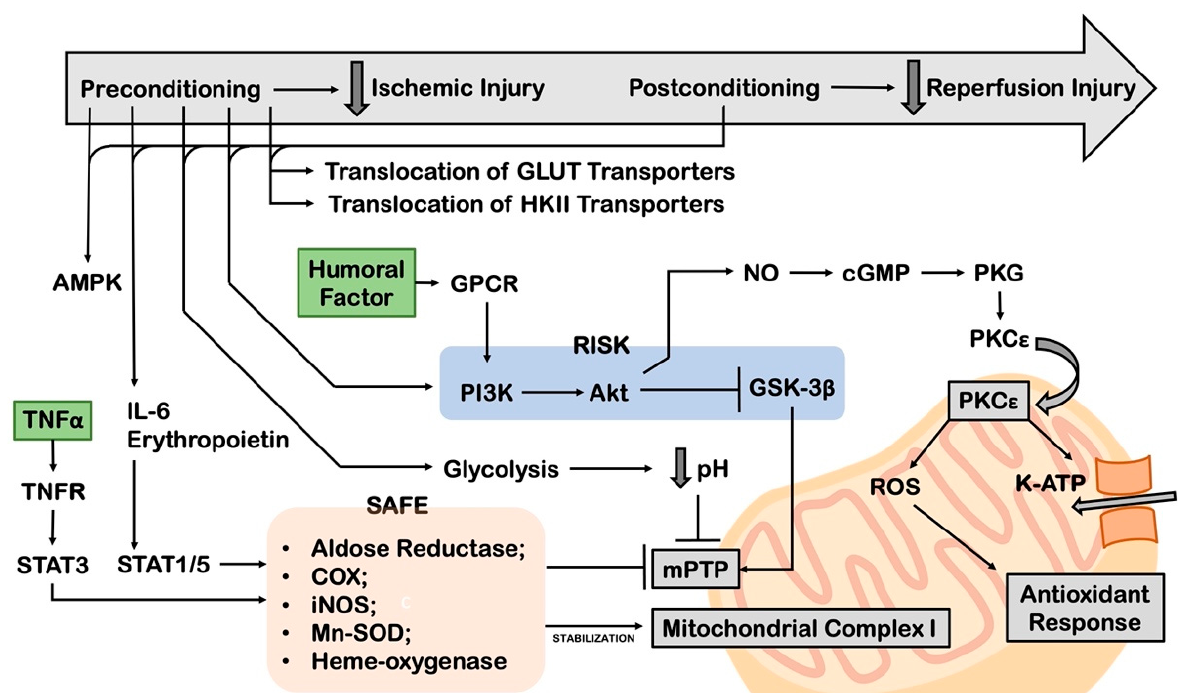
Figure 7. Schematic representation of the effects of ischemic preconditioning and post-conditioning during ischemia-reperfusion. The restoration of glycolysis and NO metabolism inhibit mPTP opening and reduce oxidative stress, improving mitochondrial function. AMPK, adenosine monophosphate (AMP)-activated protein kinase; COX, cyclooxygenase; cGMP, cyclic guanosine monophosphate (cGMP); GLUT, glucose transporter; GSK-3 β , glycogen synthase kinase 3 β ; GPCR, G-protein coupled receptor; HKII, mitochondrial hexokinase II; IL, interleukin; iNOS, inducible nitric oxide synthase; mPTP, mitochondrial permeability transition pore; NO, nitric oxide; PI3K, phosphatidyl-inositol 3-kinase; PKC, protein kinase C; PKG, protein kinase G; RISK, reperfusion injury salvage kinase; SAFE, survivor activating factor enhancement; SOD, superoxide dismutase; STAT, transducer and activator of transcription; TNF(R), tumor necrosis factor (receptor).